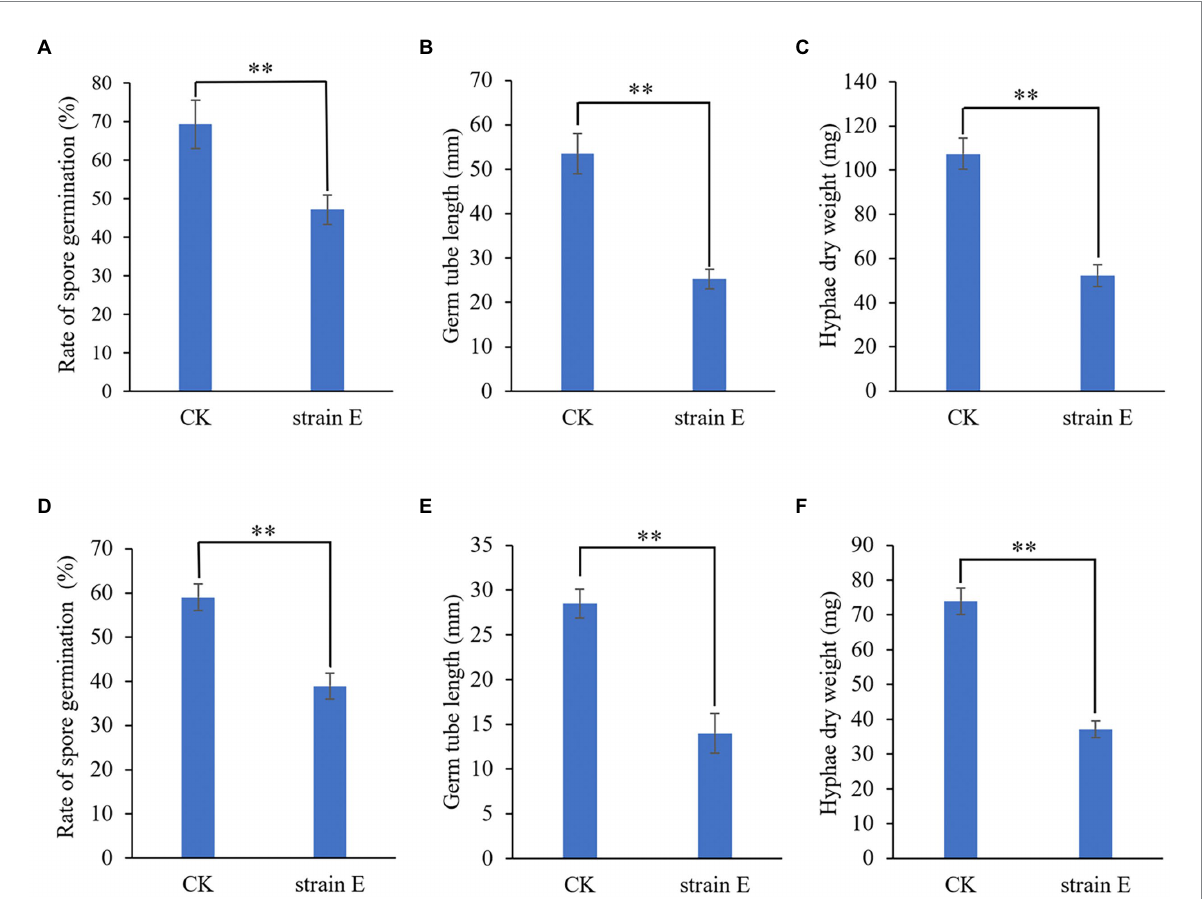
FIGURE 1 Growth inhibition of Fusarium oxysporum and Botrytis cinerea by cell-free supernatants of B. verezensis strain E. (A–C) Fusarium oxysporum . (D–F) Botrytis cinerea . (A , D) Rate of spore germination. (C , E) Germ tube length. (D , F) Hyphae dry weight. LB broth was added to the spore suspension of the fungal pathogen as a control. Asterisks indicate significant difference according to Duncan’s multiple range test. ( ** p <